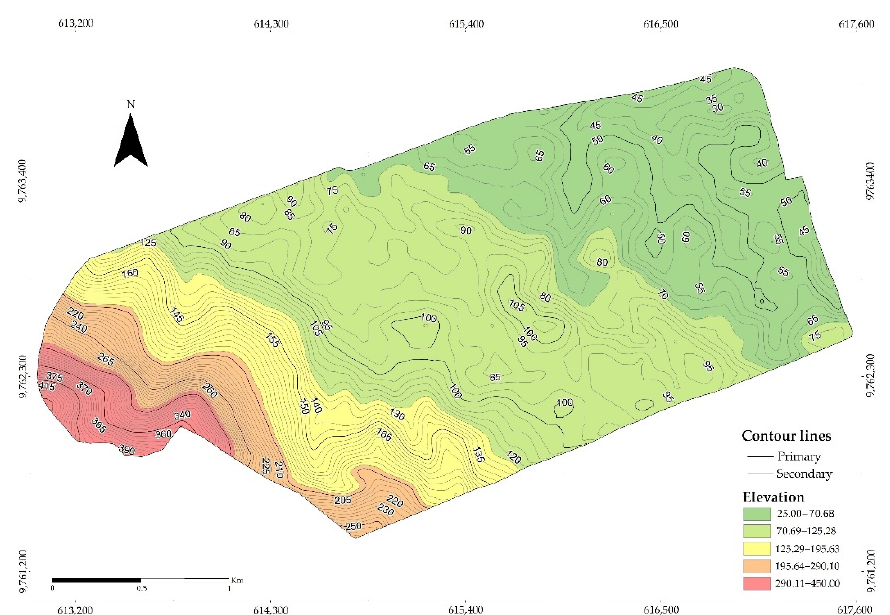
Figure 4. Topographic map of the ESPOL property.